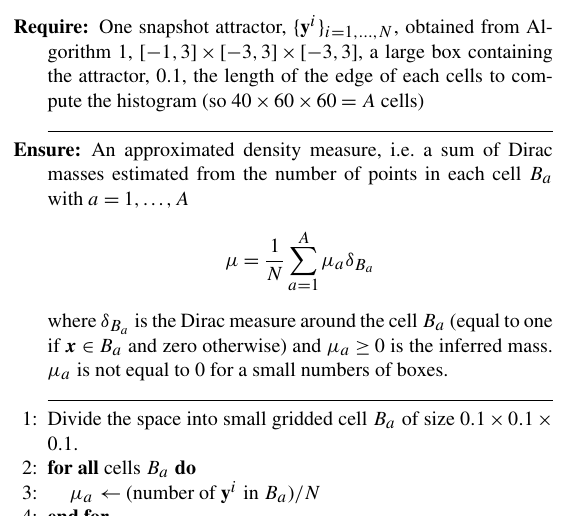
Algorithm 2 Determining the empirical invariant measure from simulated snapshot